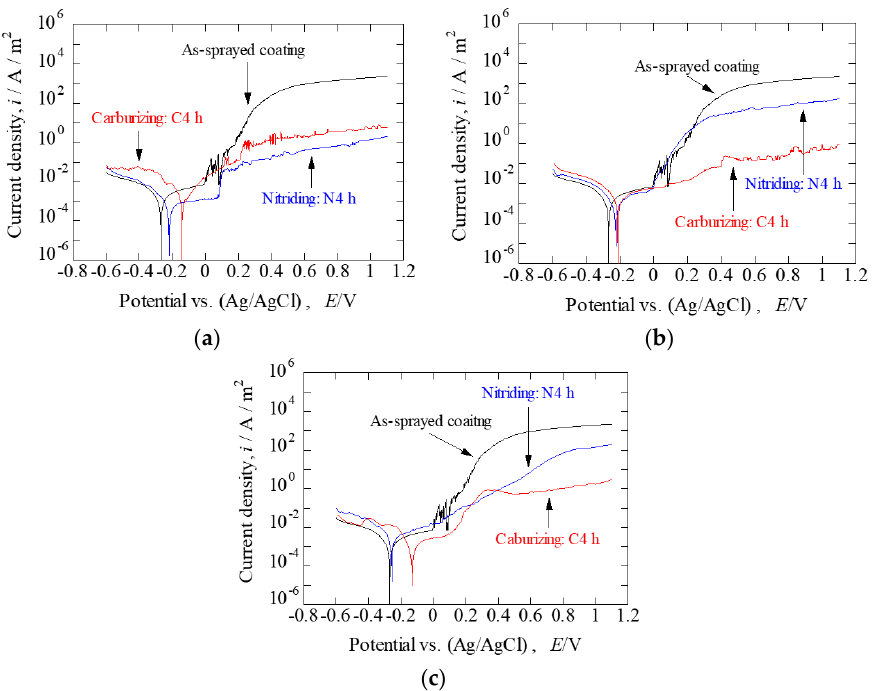
Figure 11. Anodic polarization curves in 3.5 wt % NaCl solution of the S-phase layers on cold-sprayed AISI 316L coatings obtained by 4 h carburizing and 4 h nitriding at ( a ) 400 °C, ( b ) 425 °C and ( c ) 450 °C.